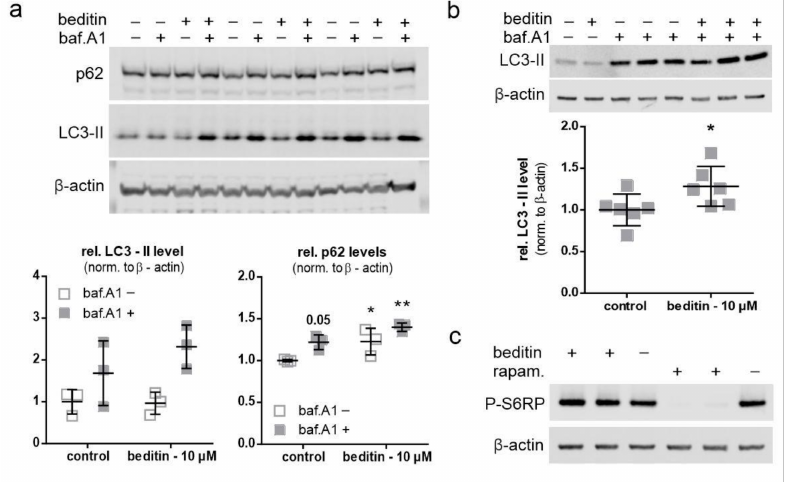
Figure 4. Beditin induces autophagy independent of mechanistic target of rapamycin (mTOR). Beditin induces autophagy in ST Hdh cells. − = control; + = indicated substance present ( a ) Western blot images of the autophagic flux assay in ST Hdh Q111/Q111 cells and respective quantification of LC3-II and p62 levels. Two-way ANOVA with Dunnett’s multiple comparison to control without bafilomycin A1 (baf.A1). p62: p = 0.053 (control + baf.A1), * p = 0.046 (beditin-baf.A1), ** p = 0.002 (beditin + baf.A1), n = 3. ( b ) Assessment of LC3-II levels by Western blot and quantification of LC3-II levels in the presence of baf.A1. ST Hdh cells were treated for 4 h with beditin (10 µ M). Unpaired t -test with Welch’s correction. * p = 0.048; n = 6. ( c ) Evaluation of mTOR signaling upon beditin treatment (10 µ M) in comparison to rapamycin (rapam.) treatment (400 nM) by S6RP phosphorylation at Ser235/236 (P-S6RP).